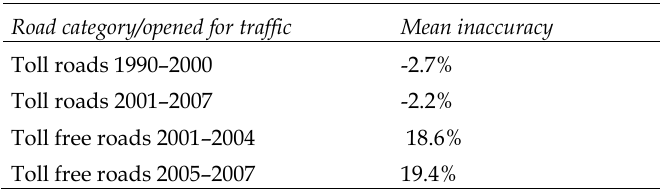
Table 5. Traffic-forecasting inaccuracies over